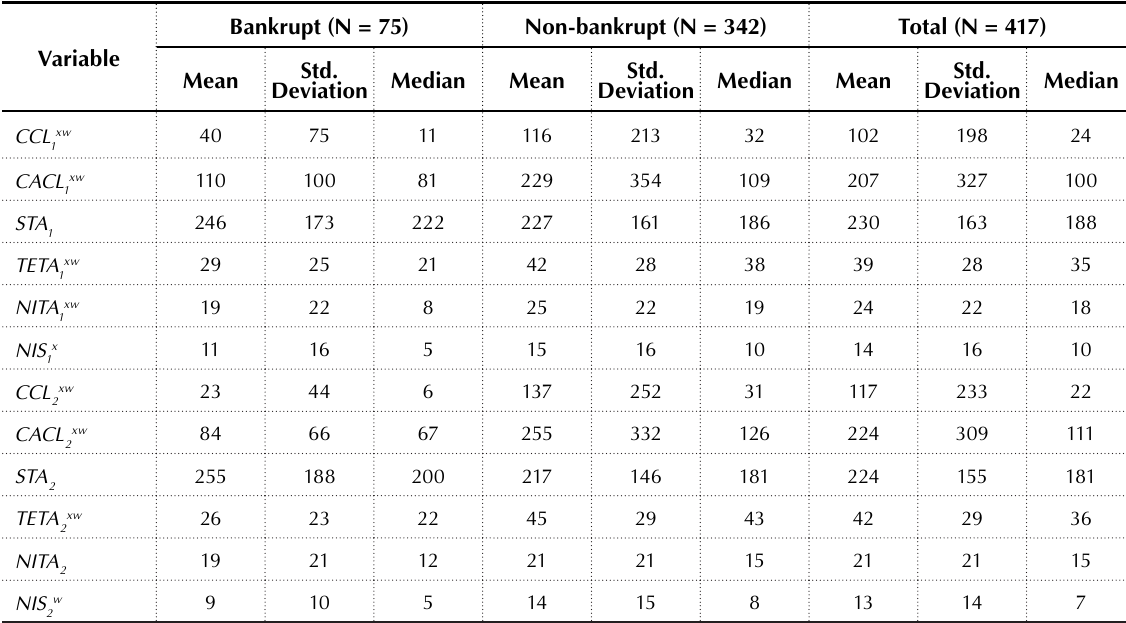
Table 2. Descriptive statistics of financial ratios for the whole sample and two types of firms,